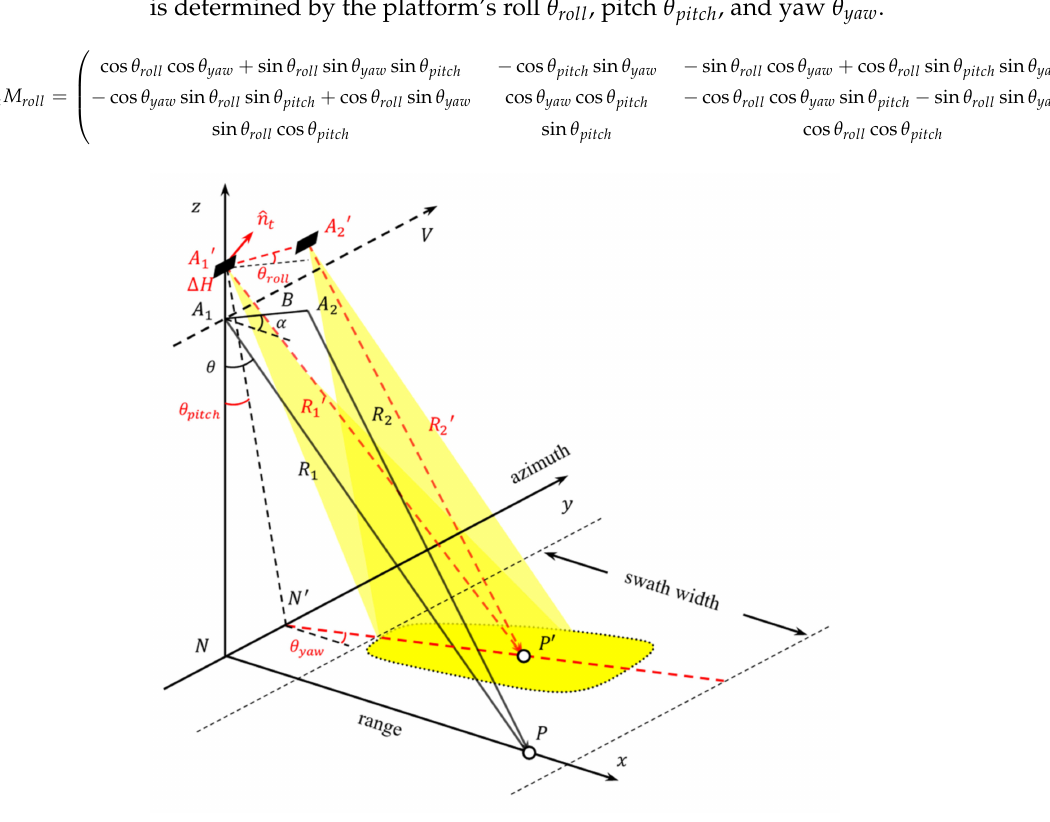
Figure 1. IRA geometry with coupling attitude altimetric